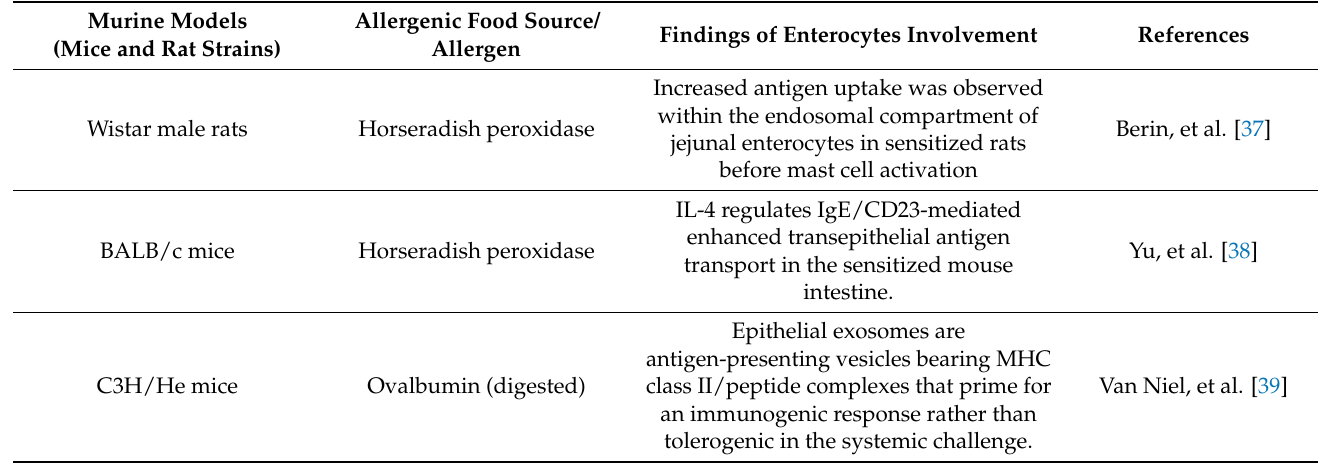
Table 2. Overview of the studies based on murine and non-murine models from which the knowledge on the involvement of enterocytes in food allergic reactions was